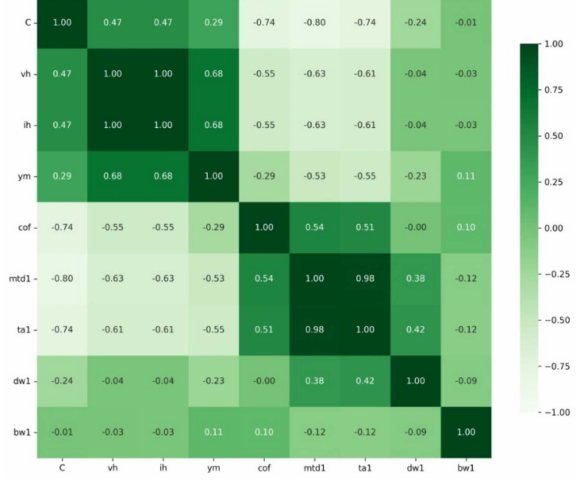
Figure 6. Heatmap for dry friction.